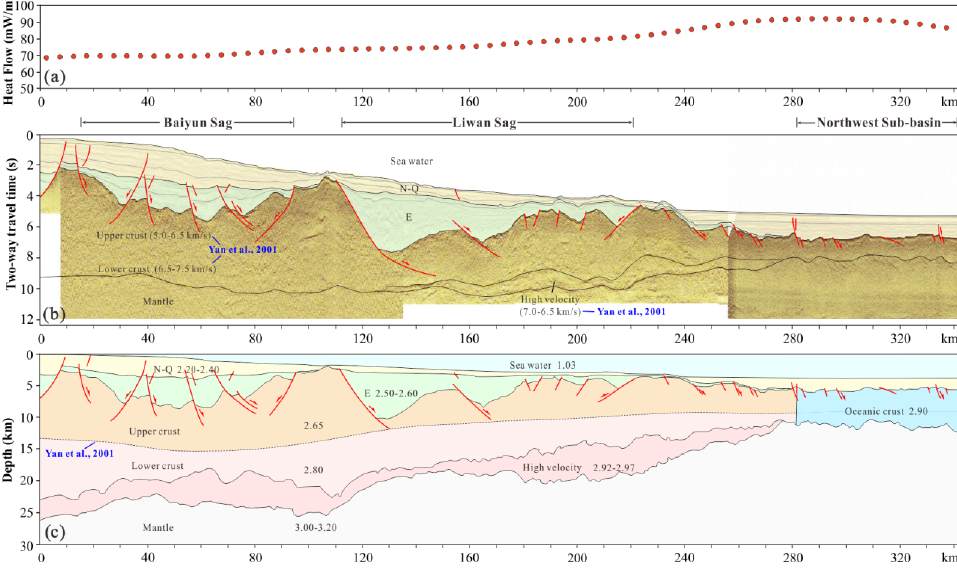
Figure 4. ( a ) The variation of surface heat flow digitized from the heat flow map of Figure 2 along profile L3. ( b ) Crustal structure from the multi − channel seismic reflection profile L3 [14]. The crustal P − wave velocity is from the OBS profiles of OBS1993, which is almost parallel to profile L3 [18] (Figure 1). ( c ) 2D density structure of lithosphere along profile L3 [14,25]. N–Q, late Oligocene–Hol ‐ ocene; E, Paleocene–early Oligocene. See Figure 1 for locations.